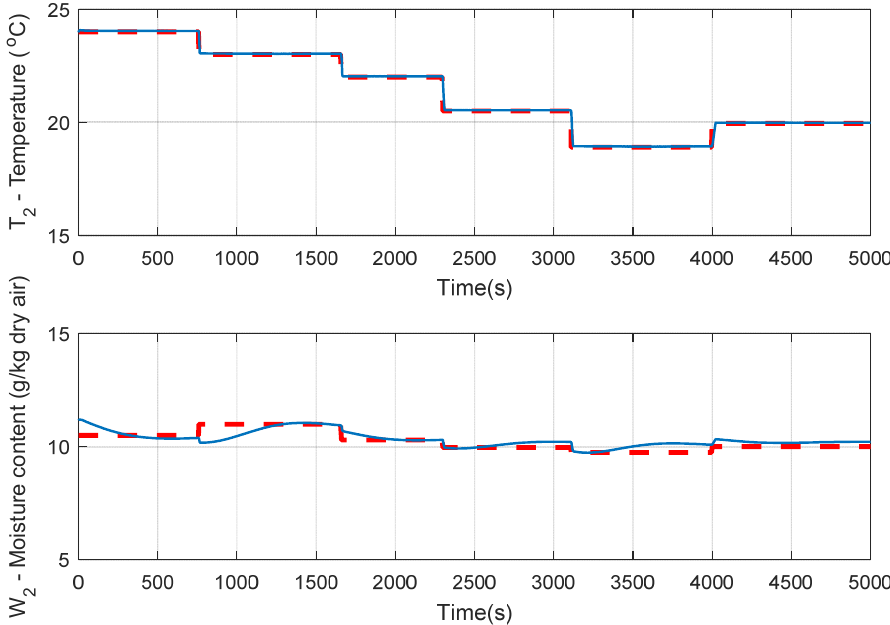
Figure 3. Tracking performance of VS DX A/C system with internal disturbances.